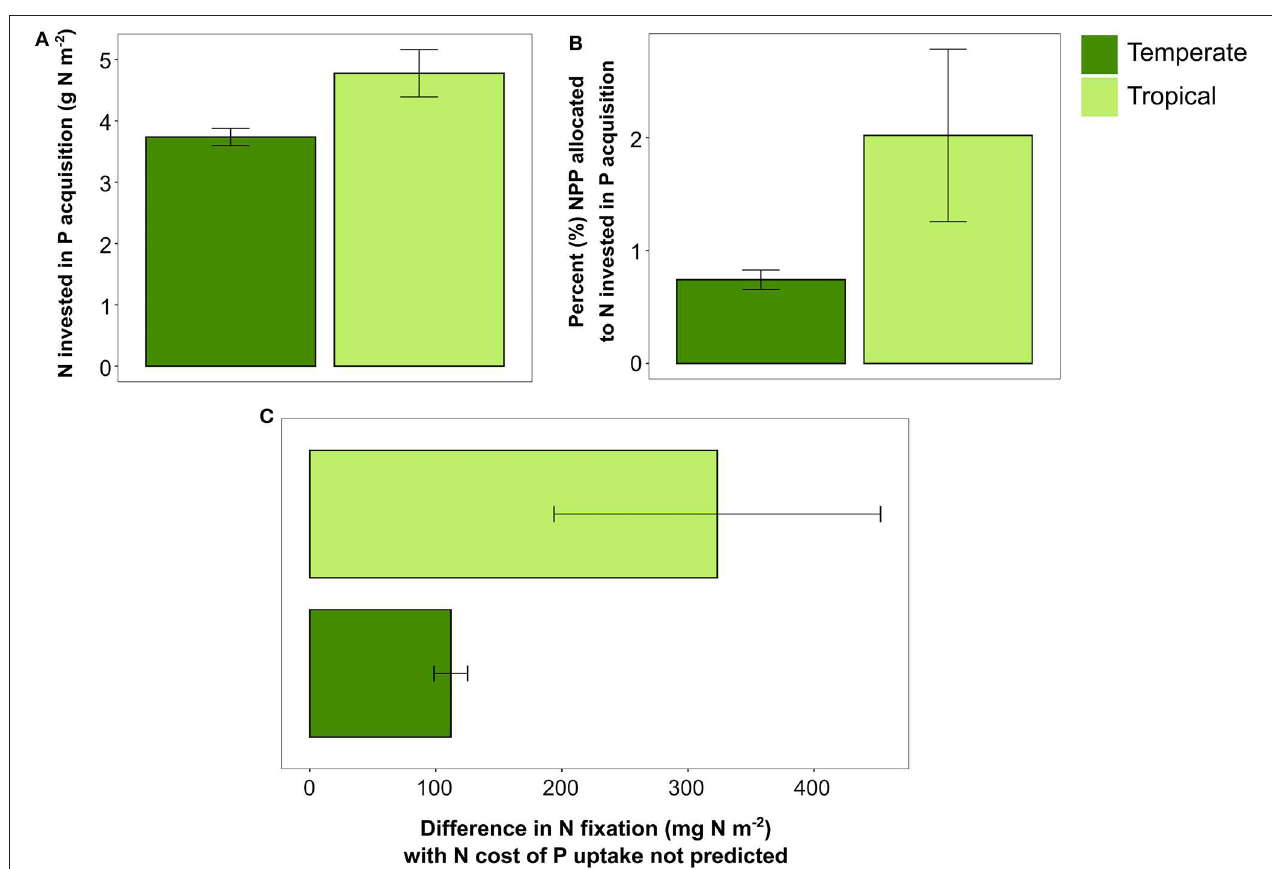
FIGURE 4 | (A) Nitrogen invested in phosphorus acquisition across temperate ( n = 45) and tropical ( n = 18) forest sites. (B) Percent NPP (mean ± SE) allocated to N invested in P acquisition in temperate and tropical forest sites. (C) Difference in N fixation between ambient fixation and N fixation with N cost of P turned off. Bars represent means ± SE, and points represent each site in temperate and tropical sites.